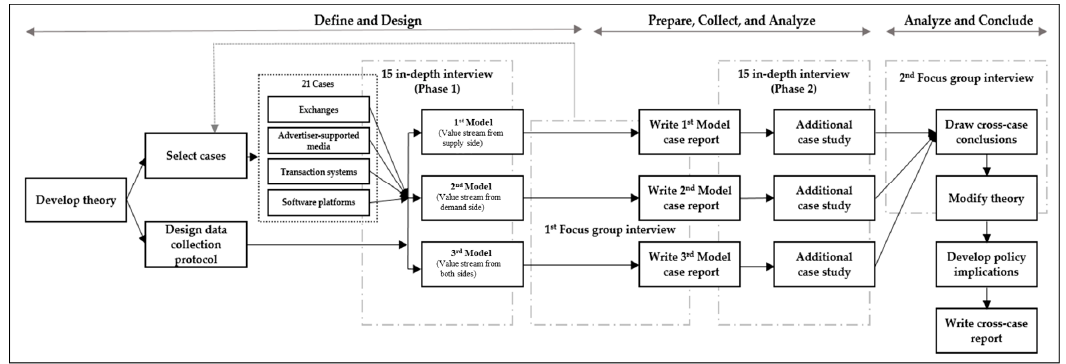
Figure 1. Data collection and multiple-case study analysis process. Source: Author’s Elaboration based on [65,70].